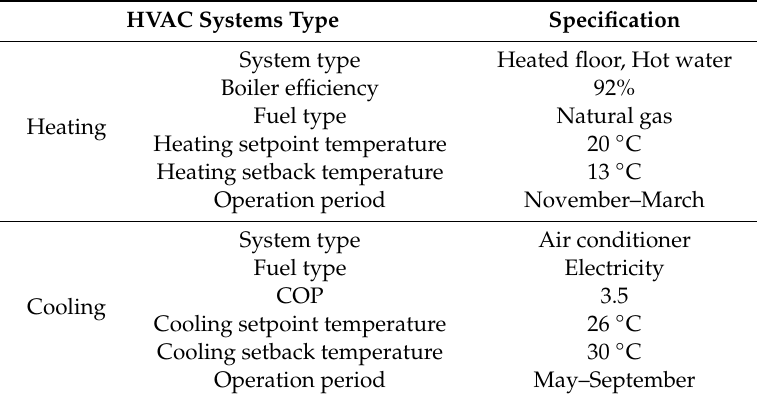
Table 5. Specifications of the heating and cooling system.